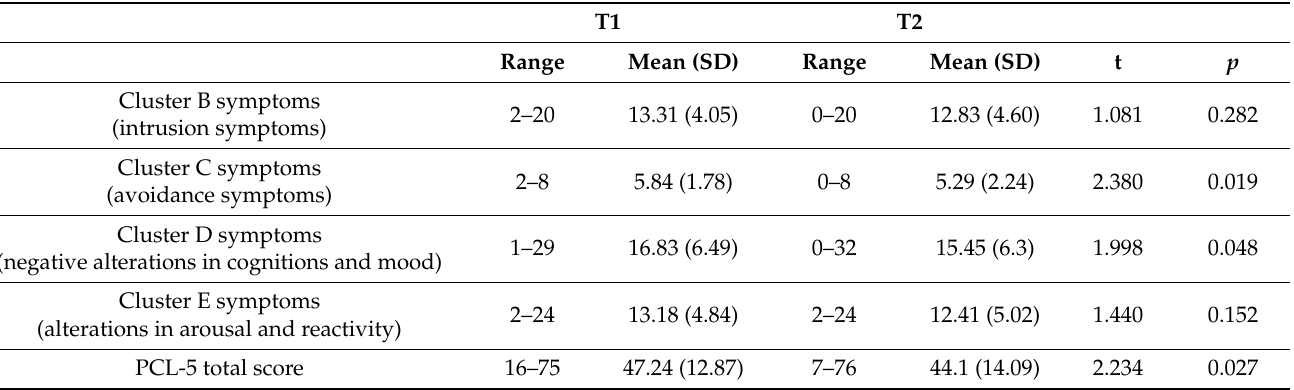
Table 2. Overall PTSD symptom severity and PTSD symptom clusters severity on two measurements during the COVID-19 pandemic *. T1 T2 Range Mean (SD) Range Mean (SD) t p